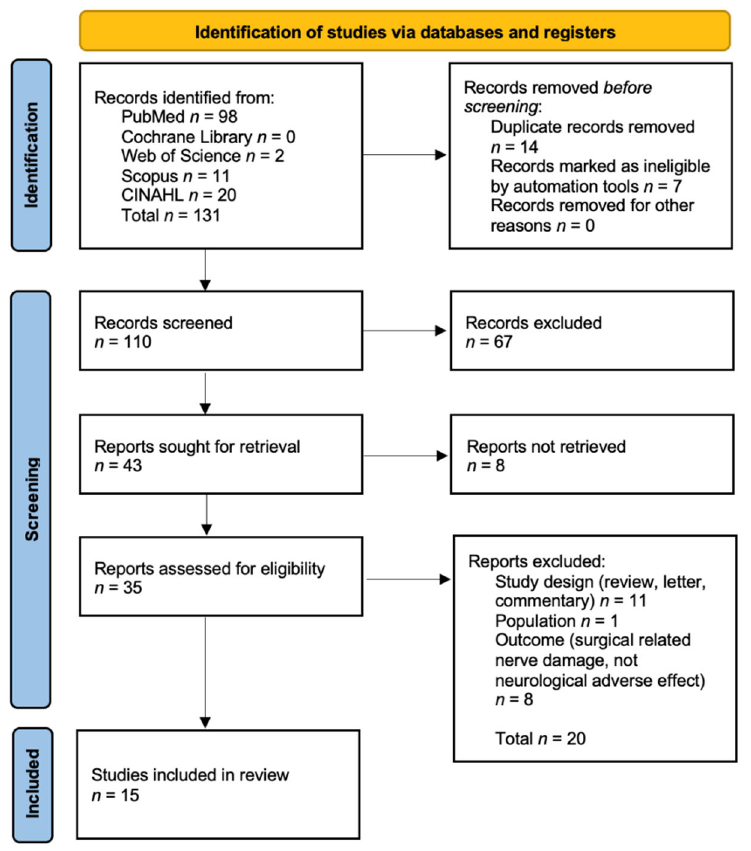
Figure 1. The flowchart of the search results and selected studies was constructed on the basis of the Preferred Reporting Items for Systematic Reviews and Meta-Analyses (PRISMA) flowchart [23].